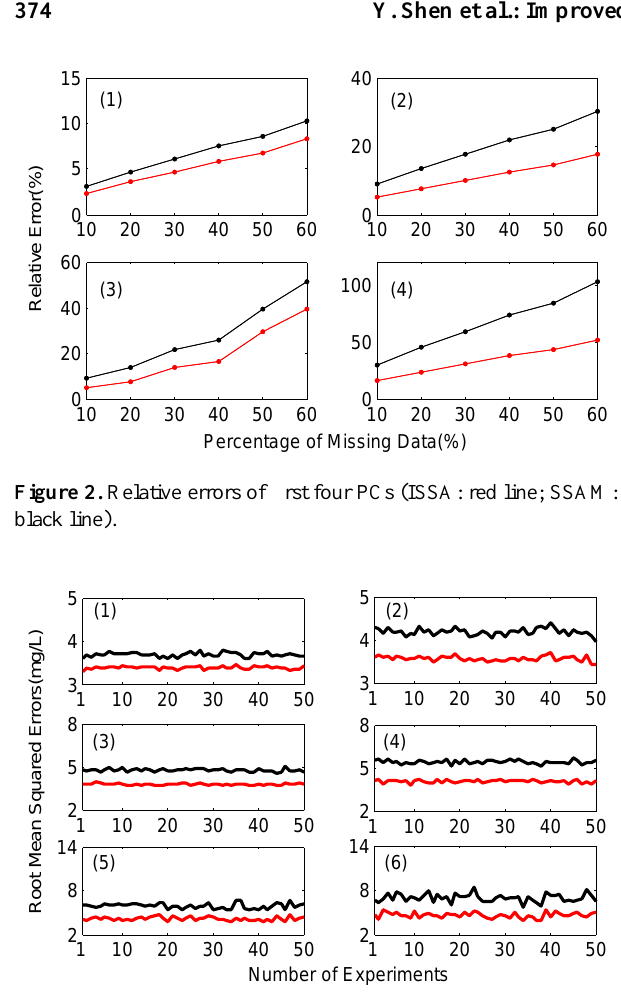
Figure 3. RMSE of 50 experiments, (1)–(6) represent percentage of missing data ranging from 10 to 60% in 10% increments.